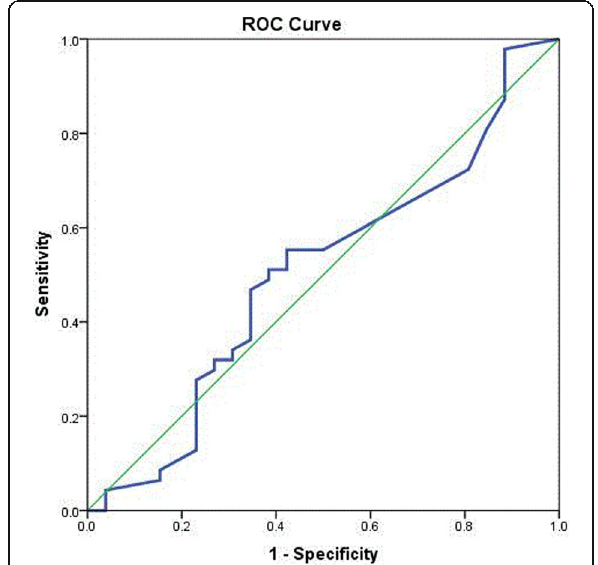
Fig. 3 ROC curve analysis of ESR between stable and exacerbation